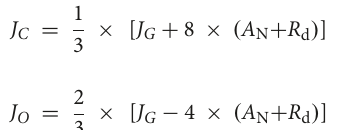
FIGURE2 Effects of exogenous melatonin (MT, 100 µ M) on the relative changes in AN (A) , gs (B) , and gm (C) after transition from 50 to